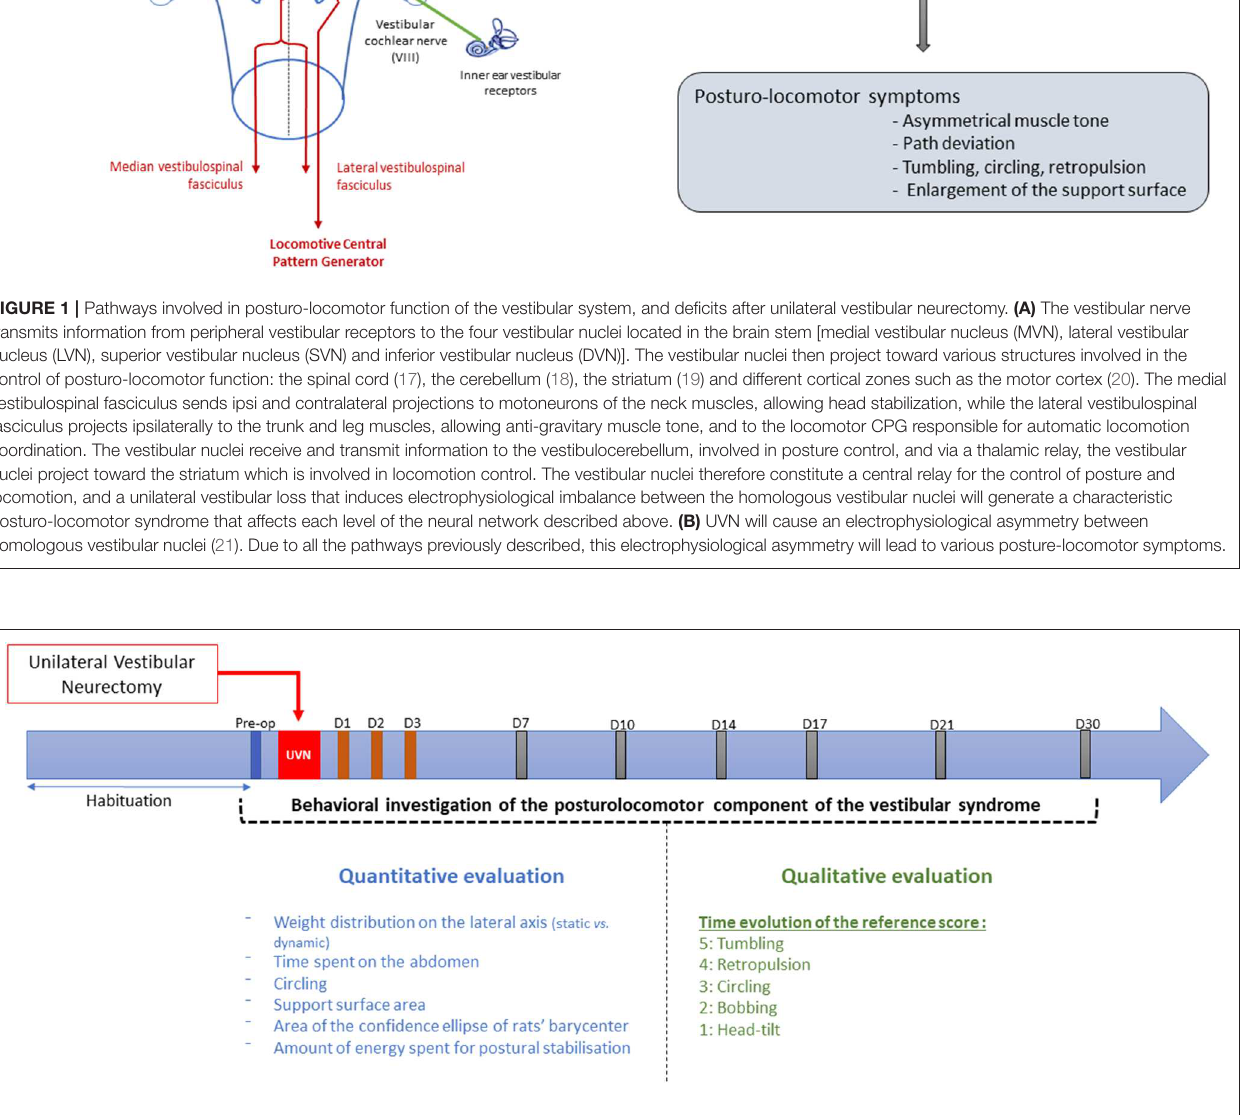
Frontiers in Neurology | www.frontiersin.org